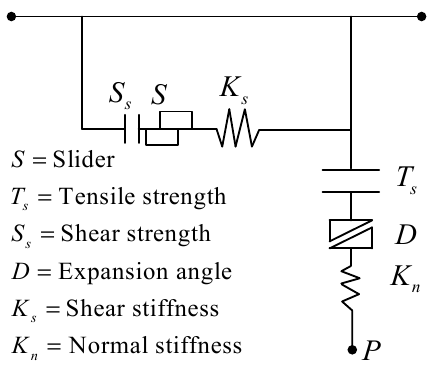
Figure 5. Schematic diagram of the interface unit principle.